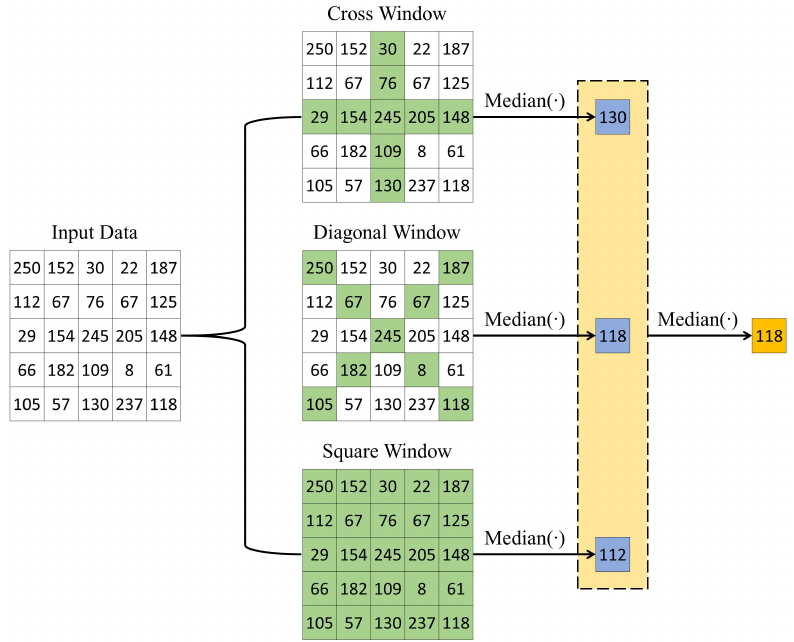
Figure 15. Example of the operation of the modified hybrid median filter